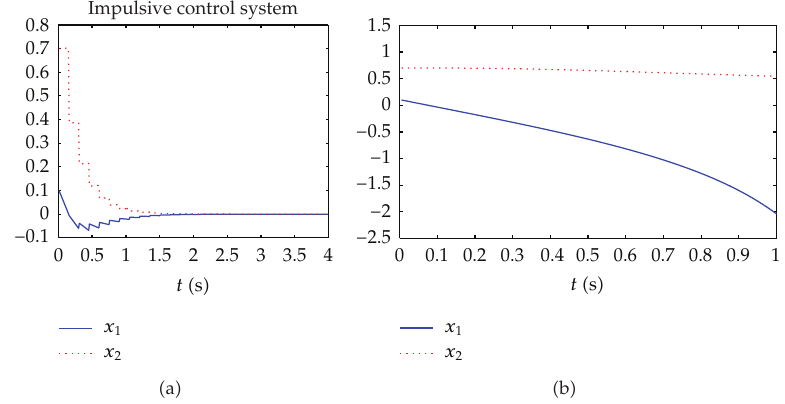
Figure 1: State diagram of predator-prey system with parameters b (cid:8) 1 / 2, and a 0 (cid:8) 1, a 1 (cid:8) 1. (cid:6) a (cid:7) shows state diagram of predator-prey system under performing impulsive control; (cid:6) b (cid:7) shows state diagram of predator-prey system without impulsive